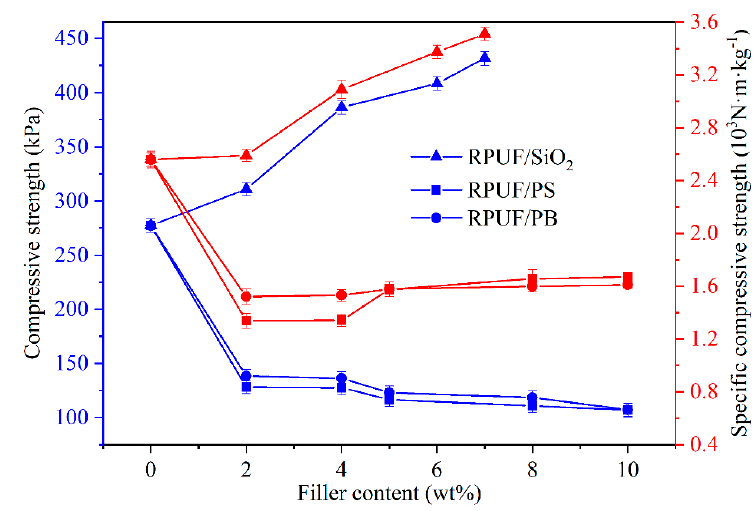
Figure 2. The compressive strength and specific compressive strength curves of prepared composite RPUFs under the deformation degree of 10%.